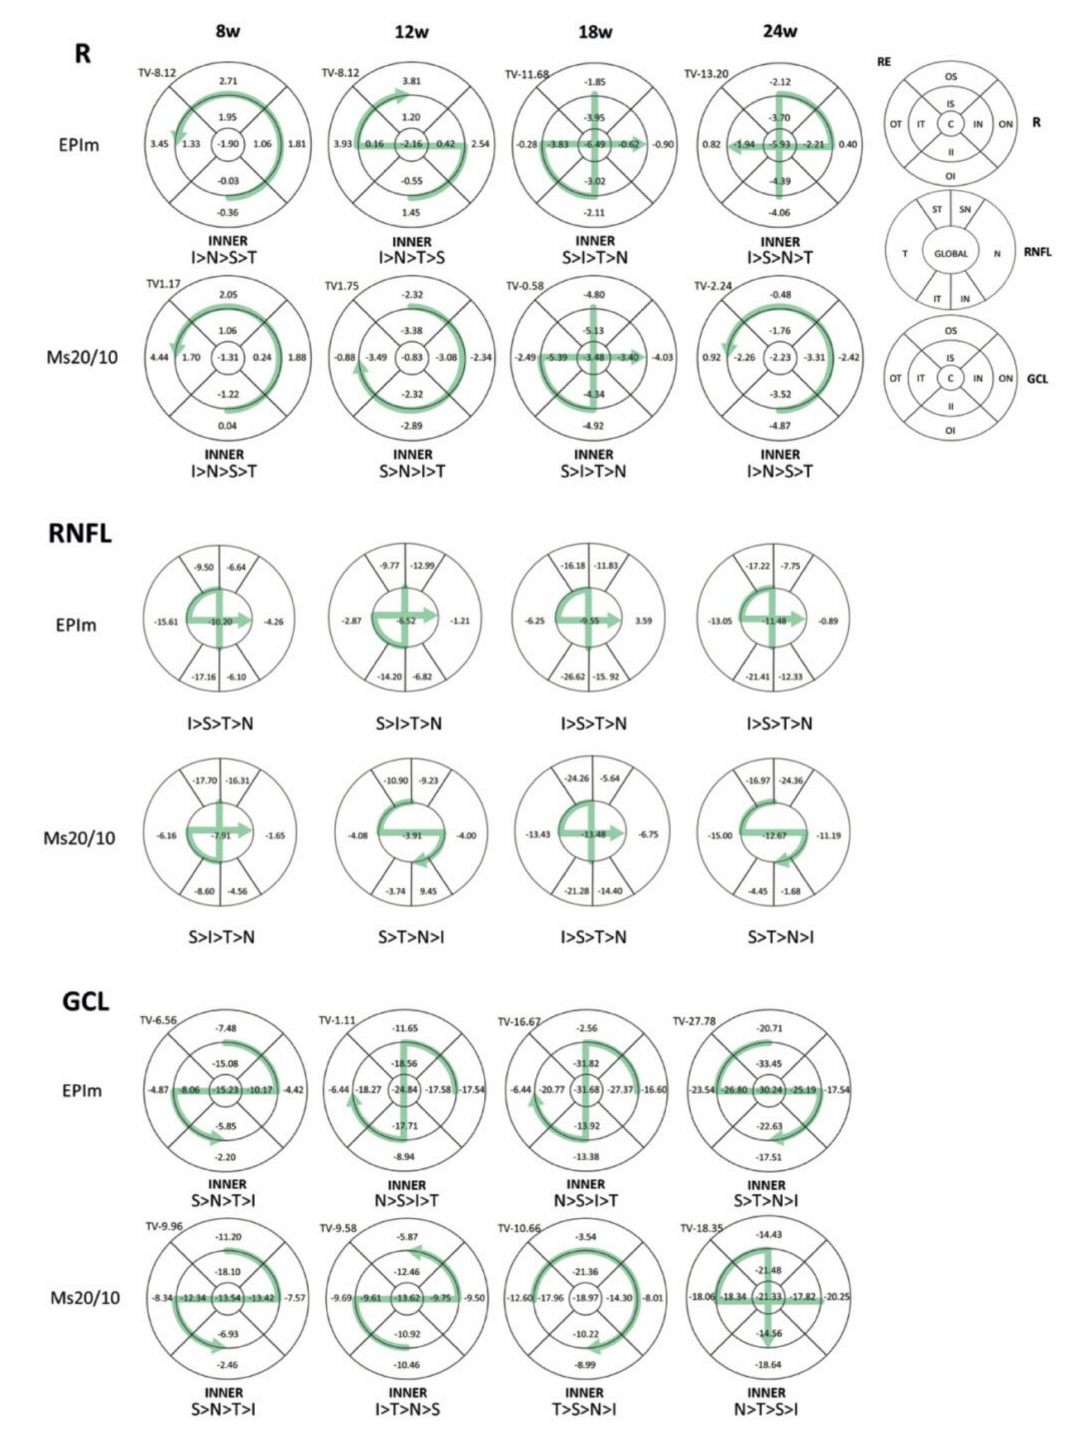
Figure 5. Neuroretinal percentage loss by optical coherence tomography sector and loss trend in both ocular hypertensive models. Abbreviations: EPIm: episcleral sclerosis model; Ms20/10: microsphere model; RE: right eye; R: retina; C: central; II: inner inferior; OI: outer inferior; IS: inner superior; OS: outer superior; IN: inner nasal; ON: outer nasal; IT: inner temporal; OT: outer temporal; RNFL: retinal nerve fiber layer; IT: inferior temporal; IN: inferior nasal; ST: superior temporal; SN: superior nasal; N: nasal; T: temporal; GCL: ganglion cell layer; TV: total volume; I: inferior; S: superior; N: nasal; T: temporal; >: higher loss